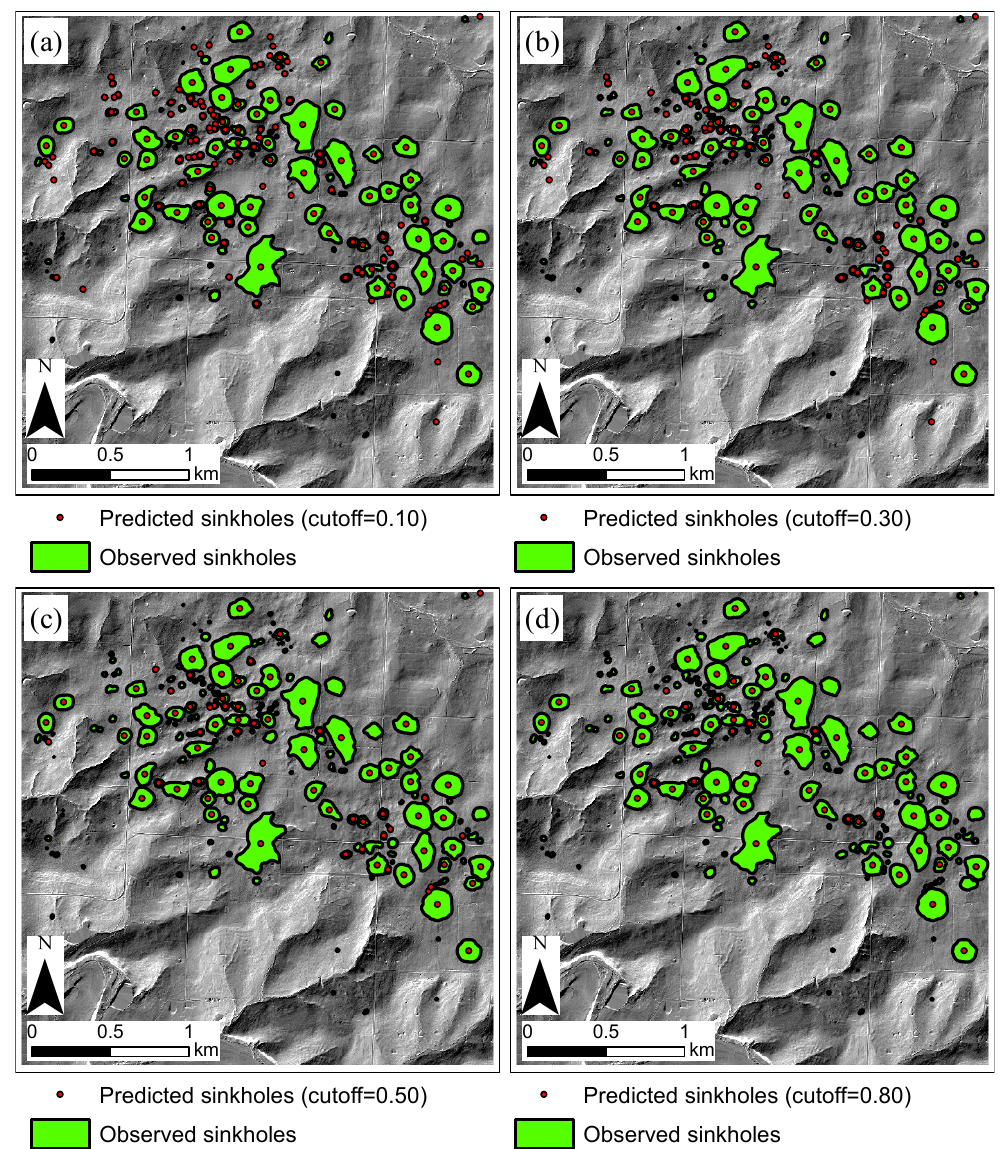
Figure 6. E ff ect of cuto ff value on sensitivity and specificity of test results when cuto ff value is: ( a ) 0.1; Figure 6. Effect of cutoff value on sensitivity and specificity of test results when cutoff value is: ( a ) ( b ) 0.3; ( c ) 0.5; and ( d ) 0.1; ( b ) 0.3; ( c ) 0.5; and ( d ) 0.8.